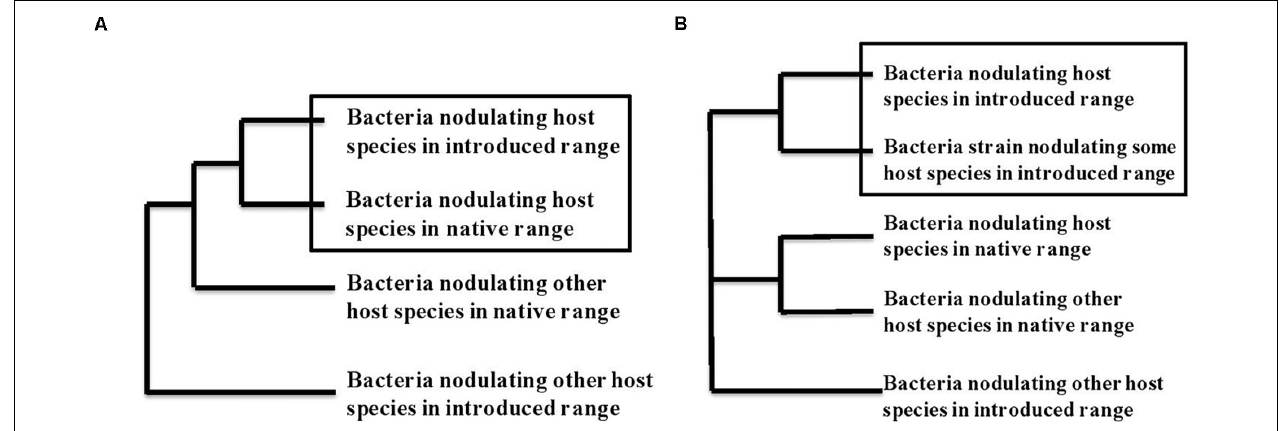
FIGURE 1 | Phylogenetic trace of co-introduction (A) versus acquisition of a new symbiotic partner (B) in a new geographical zone. (A) Depicts scenario 1: If the bacteria found associated with a host species in a new geographic area arrived via co-introduction with the host plant these bacteria should be genetically most similar to the bacteria from the same host plant in its original geographical range. In contrast in (B) , scenario 2, if hosts acquire new symbionts from the soil bacterial community in their new geographic range, we expect the strains isolated from the introduced host species to most closely resemble bacterial strains associated with one or more host species within the introduced range. We assume some geographic pattern to relationships of the bacteria, with species from the same geographic range showing more